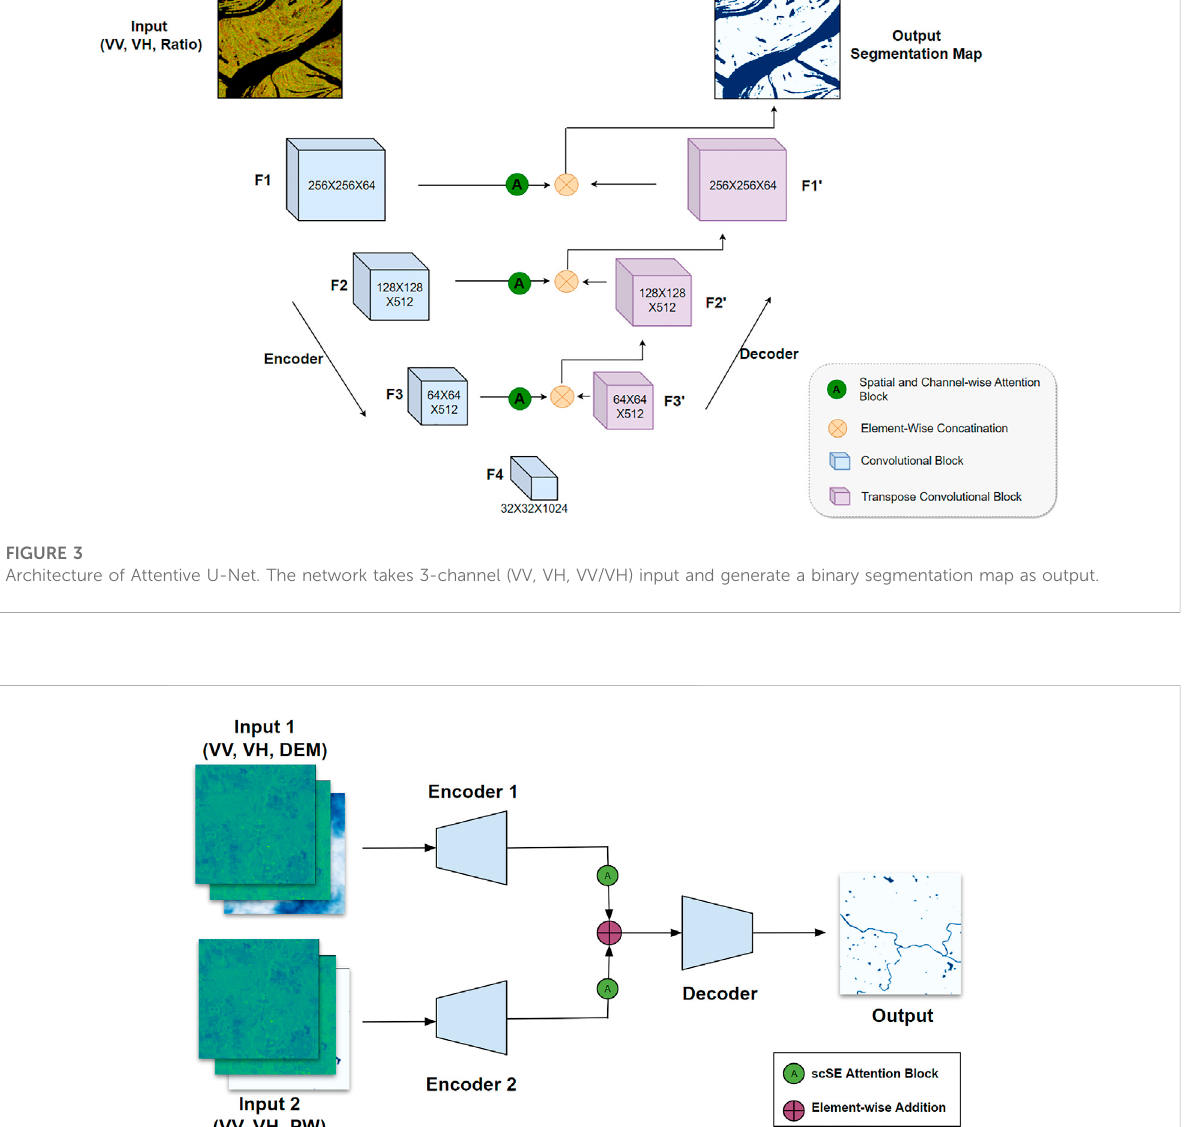
cloud shadow removal, and manual thresholding to obtain the binary fl ood map. Now, the information from the two fl ood maps is combined to prepare the fi nal ground truth masks. The quality of the ground truth masks is ensured by hand labeling all 446 tiles and manual validation (Bona fi lia et al., 2020). The ground truth mask has 0, 1, and − 1 values, where 1 represents water, 0 is the absence of water, and − 1 indicates missing data.